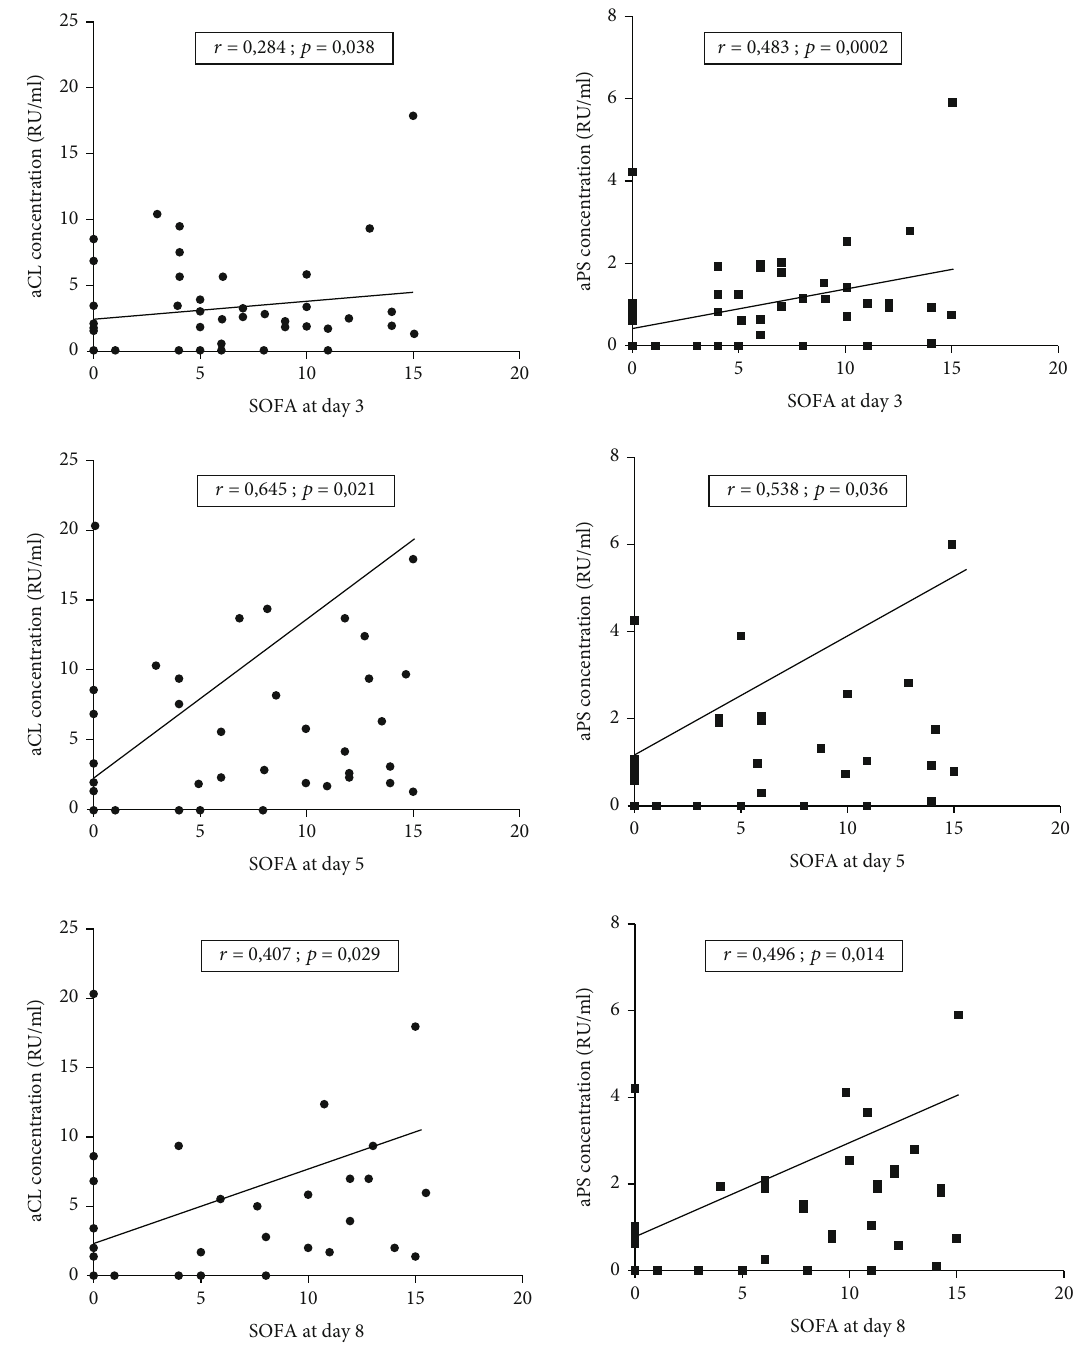
Figure 3: Correlation between SOFA score and aPL